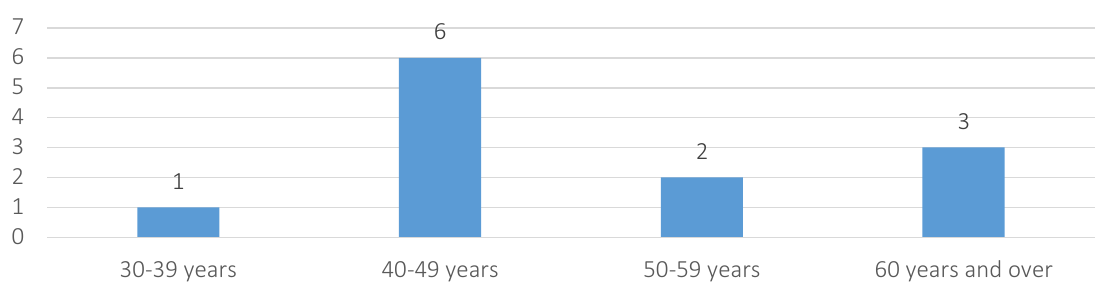
Figure 1. Age category of